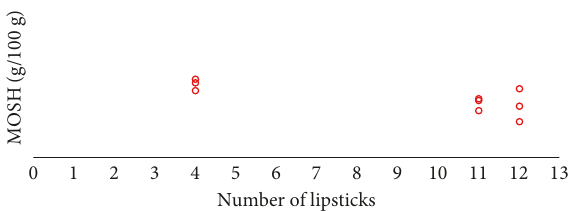
Figure 6: Homogeneity experiment of 3 strongly scattering lip- sticks from the previous experiment (Figure 5) for MOSH. Test statistic 3.55, f(0.95) 5.14, result is homogenous. (cid:31) (cid:31) –0.200.20.40.60.811.21.4